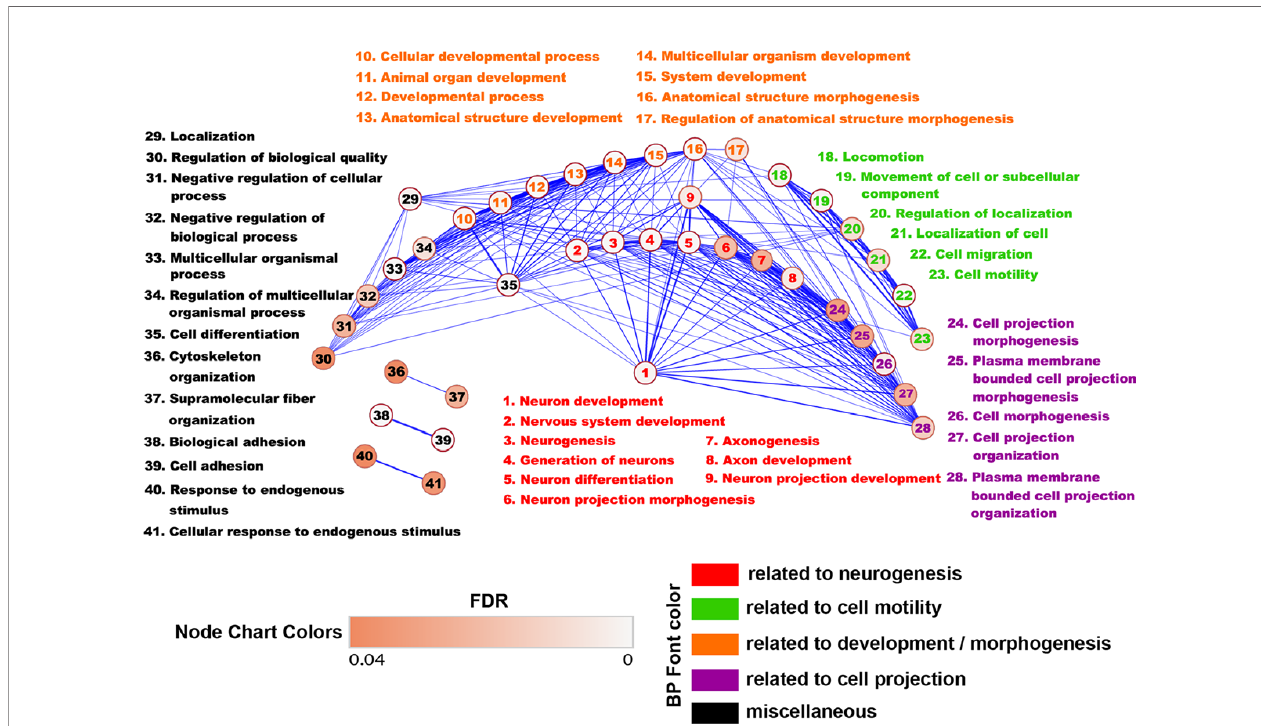
FIGURE 3 | Enrichment map of the BP differentially regulated in WT astrocytes. The BP generated from genes up-regulated only in WT astrocytes were uploaded into the EnrichmentMap application of the Cytoscape software in order to generate a network in which similar BP are placed together in close association. Annotation- and functionally similar BP were clustered together into several categories. Each node represents an individual BP. The edges between nodes represent gene overlap. Edge thickness is directly proportional to the number of overlapping genes. The nodes with no connectivity were excluded. Based on their similarity, we observed that most of the BP could be clustered together into several categories, the largest ones being development and